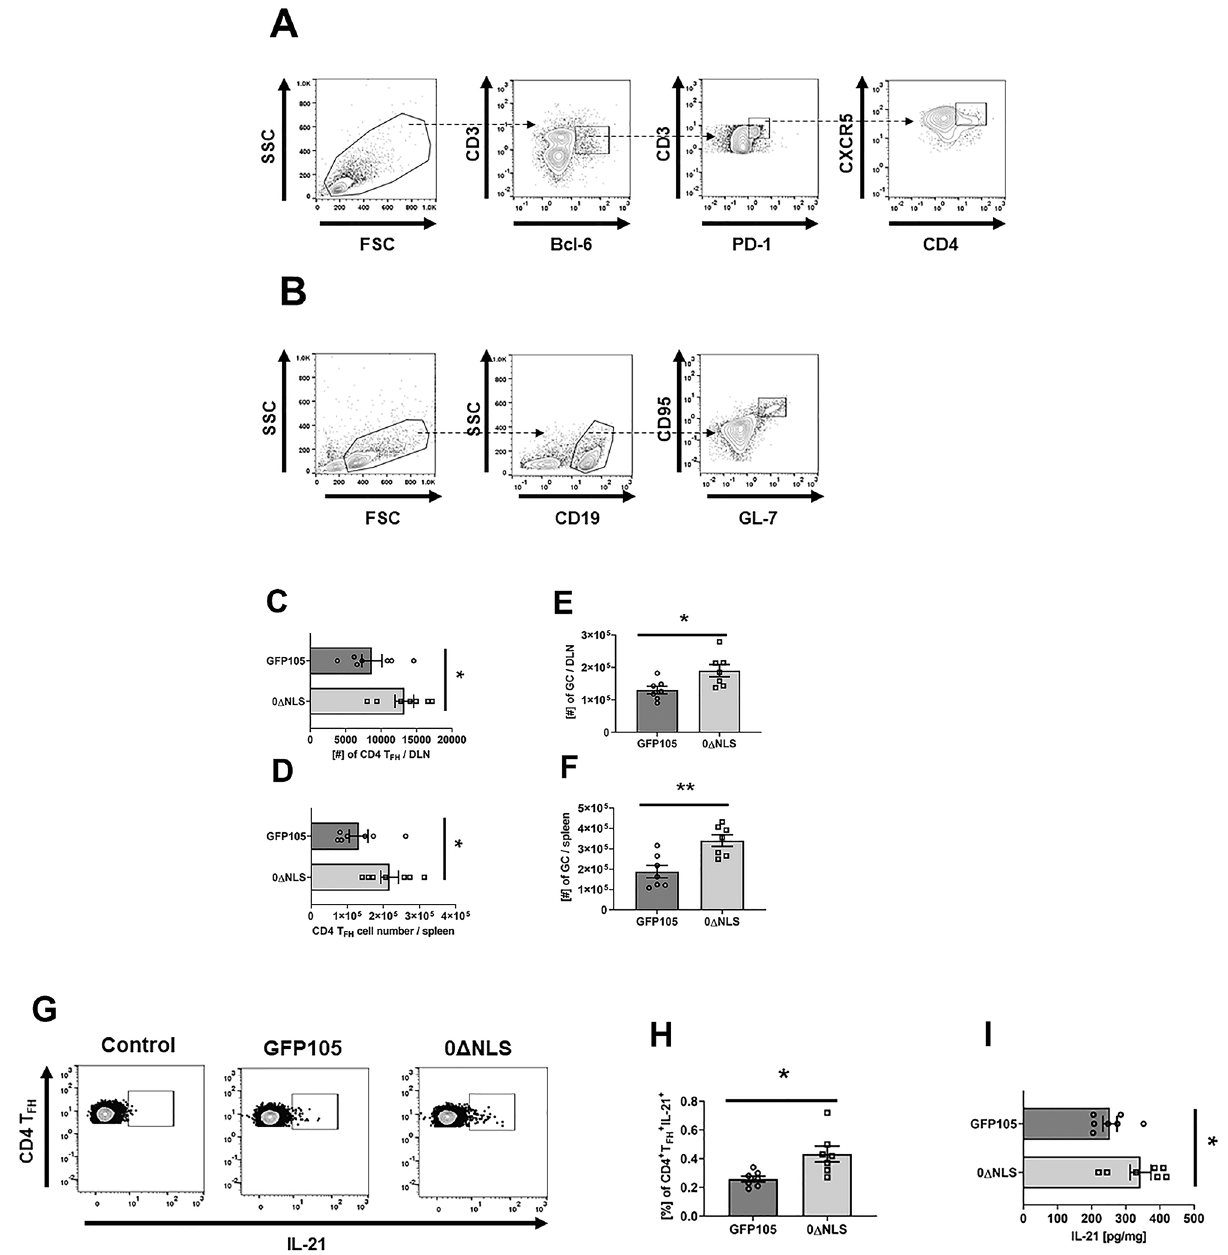
Figure 1. HSV-1 0∆NLS vaccination induces more CD4 + T FH cells along with germinal center B cells. C57BL/6 mice (n = 6–7/group) were injected in the footpad with the HSV-1 parental (GFP105) or live-attenuated HSV-1 0ΔNLS at 10 5 plaque forming units in 10 µl PBS. At day 7 or day 21 post immunization, the PLN and spleen were harvested and CD4 + T FH cell and GC B cell numbers were assessed by flow cytometry. Panel A and B present gating strategy for discrimination of CD4 + T FH cells and GC B cells, respectively. Panel C shows the CD4 + T FH cell numbers found in the PLN at day 7 post-vaccination whereas panel D shows the CD4 + TFH cell numbers found in the spleen at day 21 post-vaccination. Panels E and F present the GC B cell numbers in the PLN at day 7 and in the spleen at day 21 post-vaccination, respectively. Panel G shows a representative flow cytometry profile of intracellular IL-21 cytokine staining in CD4 + T FH cells after stimulation with PMA and ionomycin. Panel H summarizes the results showing frequency of CD4 + T FH cells expressing IL-21. Panel I includes ELISA results quantifying the amount of IL-21 recovered in the PLN at day 7 post-vaccination normalized to tissue weight. The values are presented as mean ± SEM, ** p < 0.01 and * p < .05 as determined by Student’s t